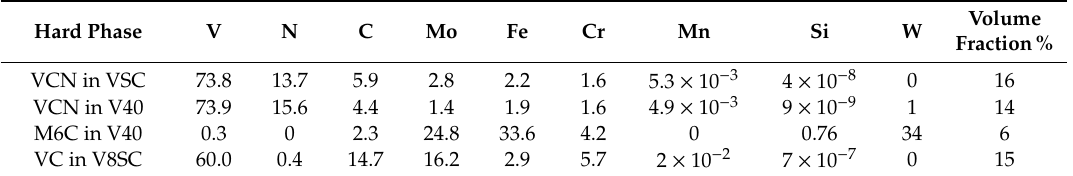
Table 4. Chemical composition wt% of the hard phase and its volume fraction presented in the tested tool